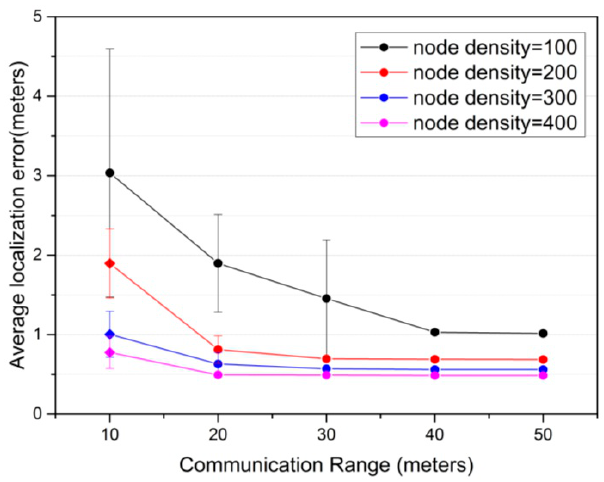
Figure 5. The effect of communication range on average localization error. In addition, the error bar denotes 95% confidence interval of average localization error.